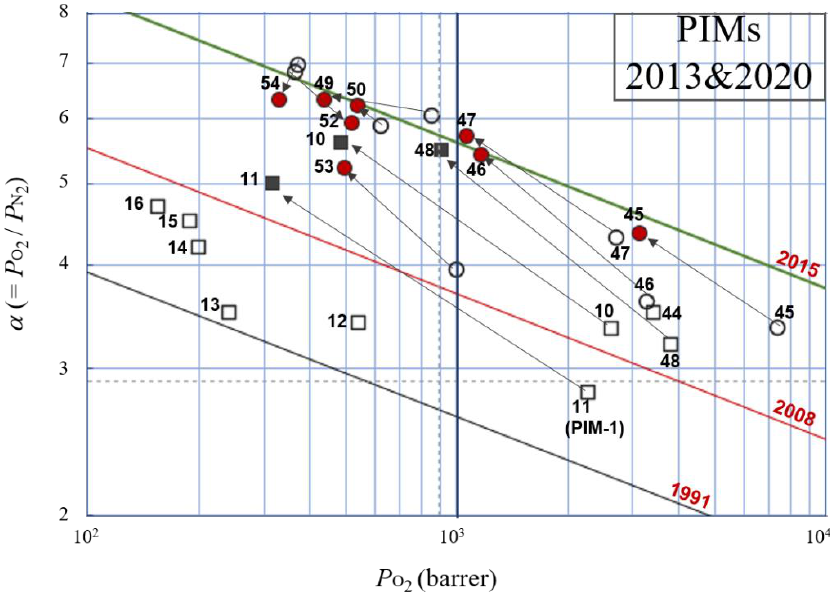
Figure 8. Plots of oxygen permselectivity through polymers of intrinsic porosities (PIMs), showing the highest α at each P O 2 reported in the literature until 2013 and 2020. For the numbers see Chart 1 (2013) and Chart 4 (2020). ● ○ : Trip-PIM, ■ □ : Spiro-PIM, ● ■ : aged values, □ ○ : none-aged values.